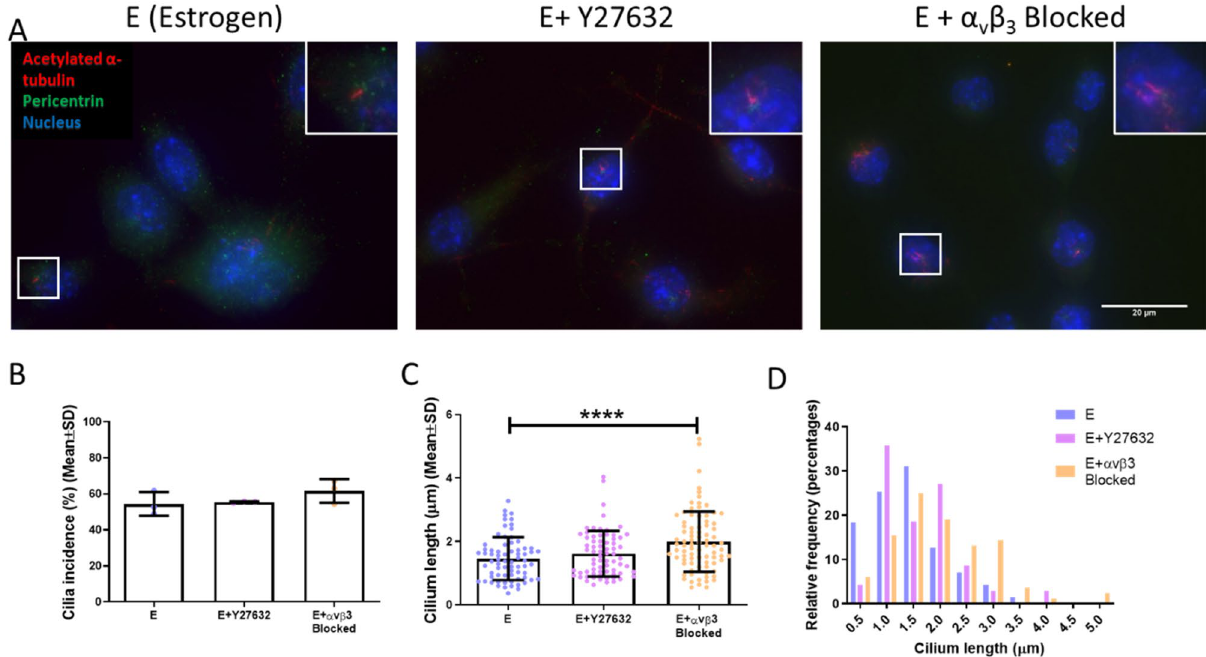
Figure 6. The effect of actin contractility inhibition (E + Y27632) and α v β 3 antagonism (E + α v β 3 antagonism) on MLO-Y4 primary cilium incidence and length. (A) Immunocytochemistry images showing acetylated α-tubulin, pericentrin, and nuclei staining (N = 3, n ≥ 70 cells per group). Quantification of the images showing (B) primary cilium incidence, (C) primary cilium length, and (D) distribution of primary cilia lengths. (Student’s t-test, ****p <